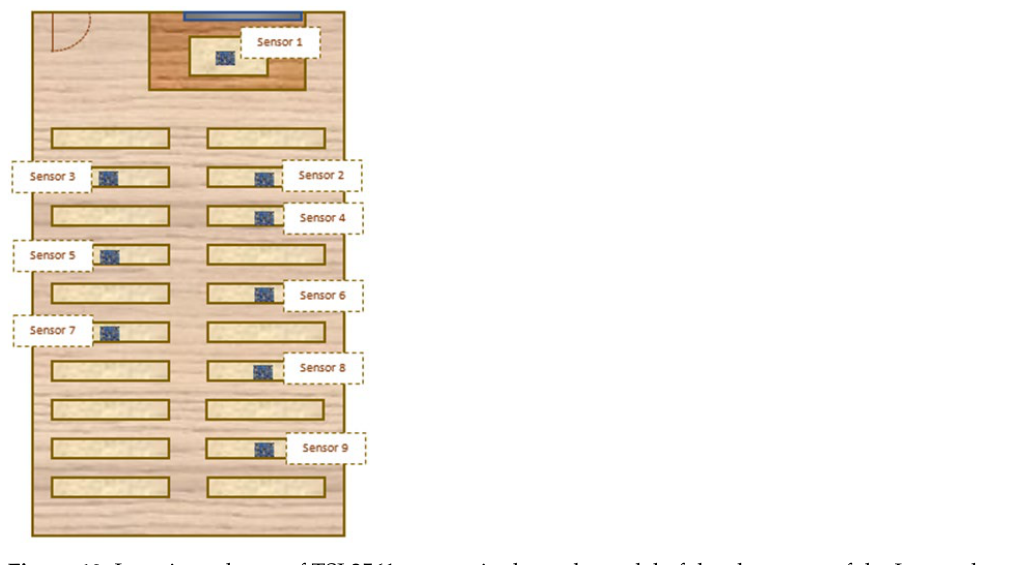
Figure 12. Connection diagram for the intensity regulator of the artificial lighting system based on LED technology. 2.5. Automation System According to what has been said, the Arduino MEGA 2560 board oversees managing and controlling the monitoring system, the regulated artificial lighting system and the movement of the stepper motors in charge of controlling the movement of the heliostats (Figure 13). The control strategy consists of a continuous reading of the illuminance through the sensors. Depending on whether the minimum value established for this type of room is reached, the heliostats (which increase the natural illumination) are activated, or the system is left with sunlight. If the minimum illuminance is not achieved with natu- ral light (heliostats plus room illumination), artificial lighting is used. Figure 14 show the connection of the Arduino MEGA 2560 board.